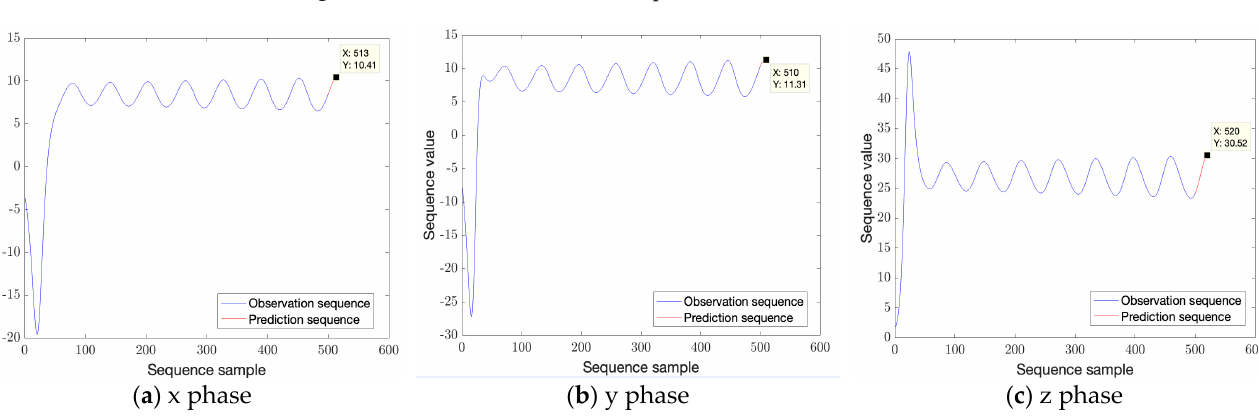
Figure 4. Henon chaotic time series prediction results.